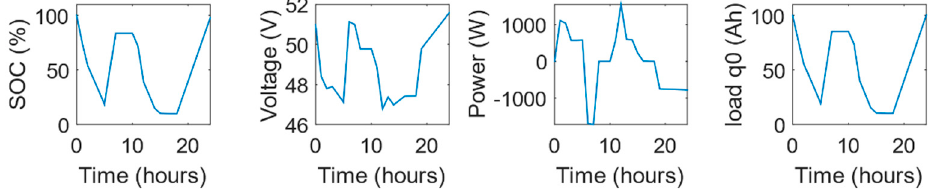
Figure 17. BESS parameters. Figure 17. BESS